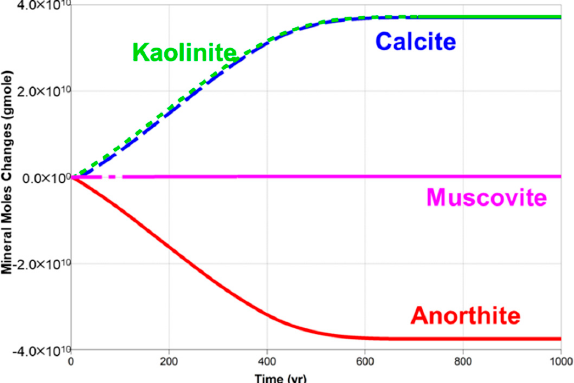
Figure 12. Spatial distribution of the change in moles of calcite in the dissolved CO 2 scenario.